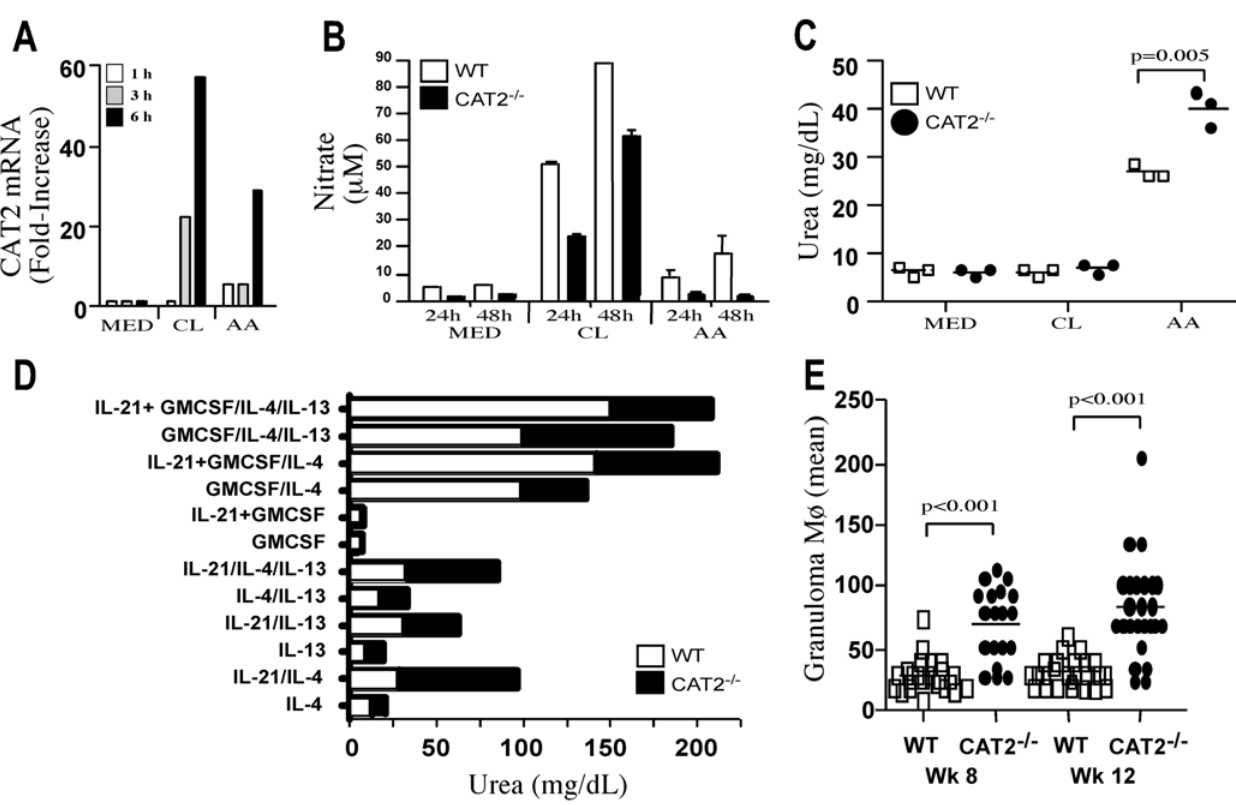
Figure 7. CAT2 2 / 2 BMM w display increased arginase activity but reduced NO responses. A. Messenger RNA for CAT2 is induced in BMM w following classical (CL) or alternative activation (AA). BMM w were incubated with medium alone (MED), IFN- c /LPS (100 U/ml/100 ng/ml, CL), or IL-13/ IL-4 (20 ng/ml, AA) for 1–6 hrs. Total RNA was isolated from individual wells and CAT2 expression was analyzed by RT-PCR. The supernatants were also collected. B. NO expression by activated CAT2 2 / 2 BMM w is impaired following classical (IFN- c /LPS) or alternative activation (IL-13/IL-4). Supernatants were assayed for nitrate levels 24 and 48 hr post-stimulation. C. Urea production (a measure of arginase activity) was assessed in WT and CAT2 2 / 2 BMM w ’s following stimulation with CL or AA stimuli. D. CAT2 2 / 2 BMM w display increased arginase activity when exposed to multiple ‘‘alternative’’ activating stimuli. WT and CAT2 2 / 2 macrophages were stimulated with various combinations of IL-21, GM-CSF, IL-4 and IL-13 (all 20 ng/ ml). E. Macrophages in granulomas at 8 and 12 wk post-infection with S. mansoni (% adjusted proportionally by granuloma size). Spots represent the mean of 30 granulomas analyzed per mouse.